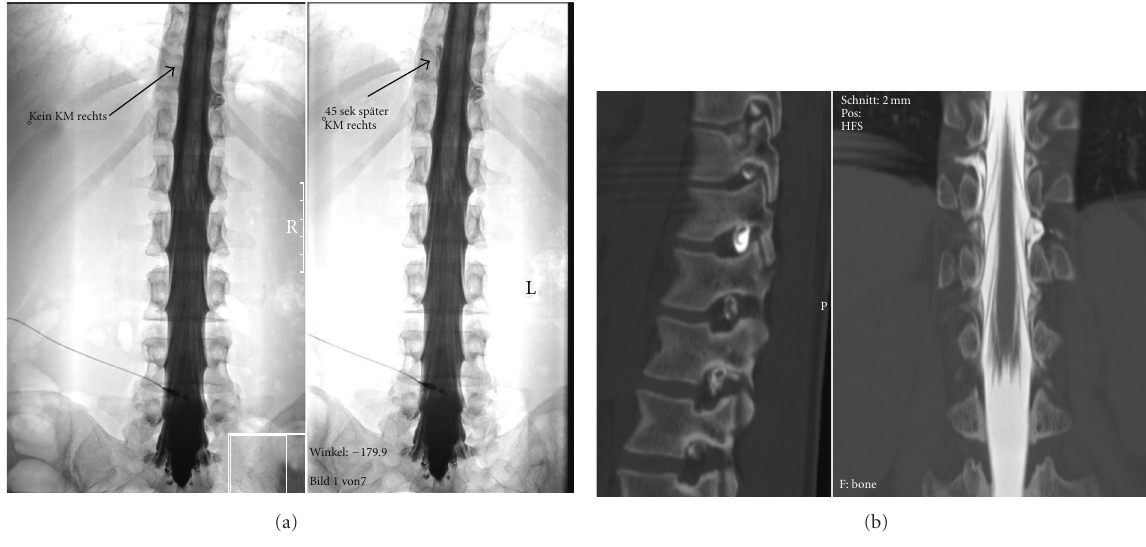
Figure 8: Spinal CSF leak causing subdural hematoma. (a) Left: contrast leakage to the left at the level of the D11 root. Right: 45 seconds later, contrast has flown around the dural sac and is exiting the spinal canal to the right. The dynamic series easily allows to study these flow dynamics and avoids misinterpretations. (b) Sagittal (left) and coronal (right) reformatted images from the subsequent myelo-CT show leakage in the left D11/12 foramen and contrast leakage to the right one segment above. This static study does not allow to exactly determine how contrast flows in and around the dural